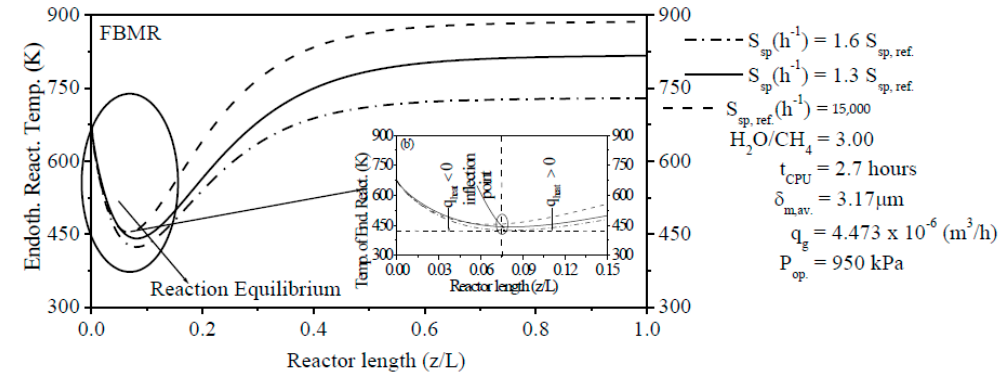
Figure 5. Effect of the S sp on the ERT along the reaction zone length from PBMR on Ni/ γ -Al 2 O 3 .